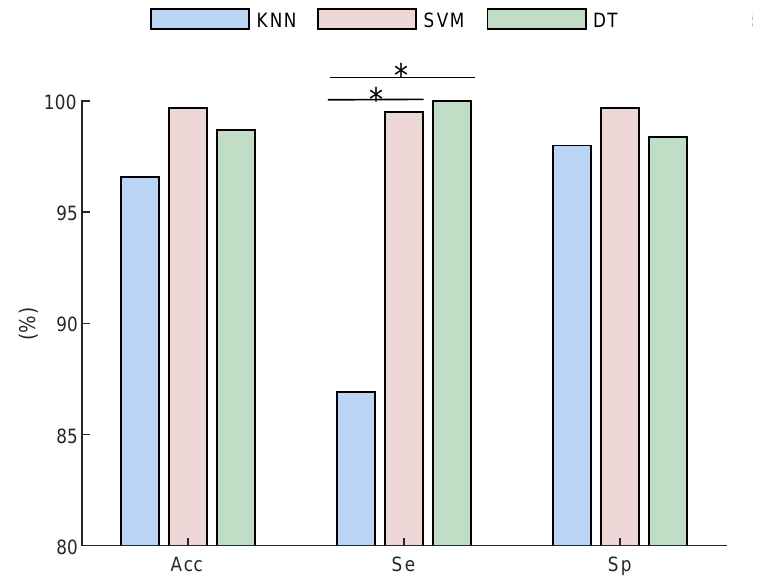
Figure 5. The performance comparison of all three classifiers. * stands for p <